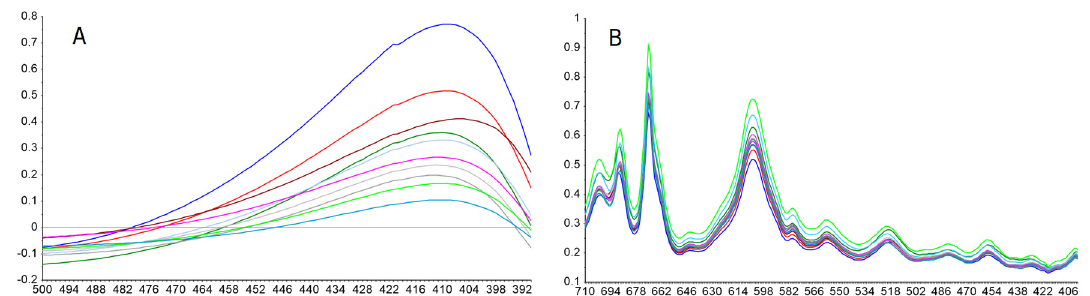
Figure 4. VIS (500–390 nm) ( A ) and MID–FTIR (710–400 cm − 1 ) ( B ) spectra of PIMs after equilibration with different cadmium (II) initial concentrations in the aqueous phase (1.63 × 10 − 6 –3.82 × 10 − 4 mol